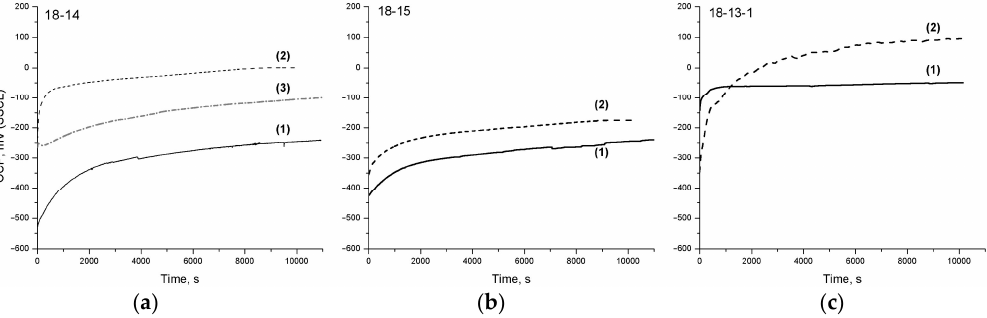
Figure 4. OCP curves of ( a ) 18-14, ( b ) 18-15, and ( c ) 18-13-1 alloys (1) before and (2) after TMT, and (3) the 18-14-based foam material in Hanks’ solution at 310 K.